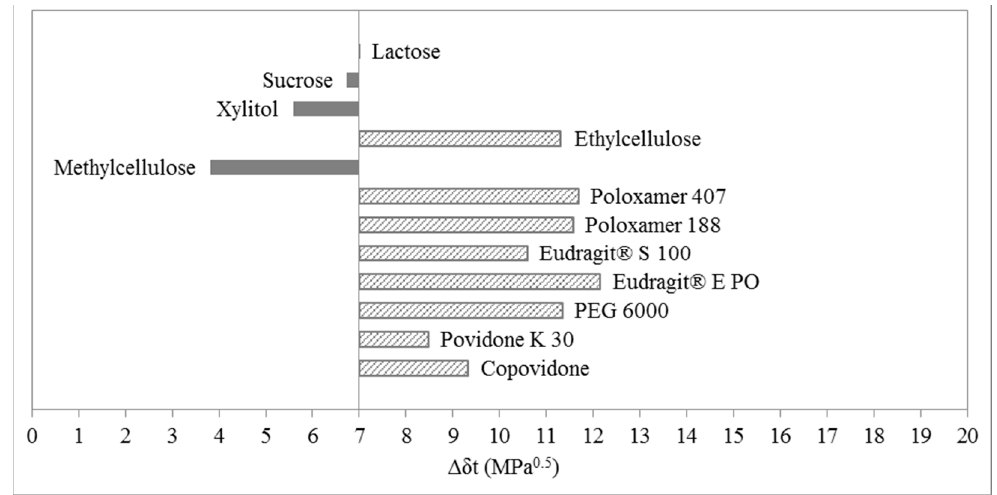
Figure 7. Bar graph according to Greenhalgh for ibuprofen lysinate; solubility parameters of ibuprofen lysinate were obtained using EHA.